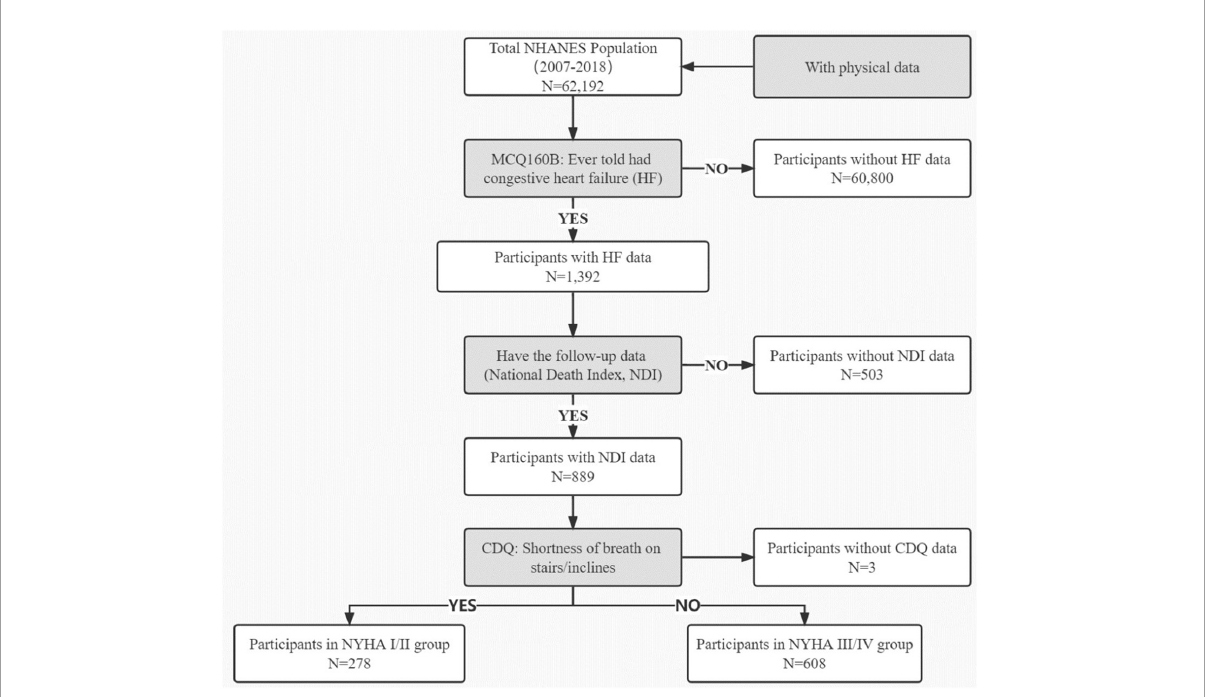
FIGURE1 Study flowchart. NHANES, National Health and Nutrition Examination Survey; HF, Heart failure; NDI, National Death Index; CQD, Cardiovascular Health Questionnaire; NYHA, New York Heart Association Classification of Heart